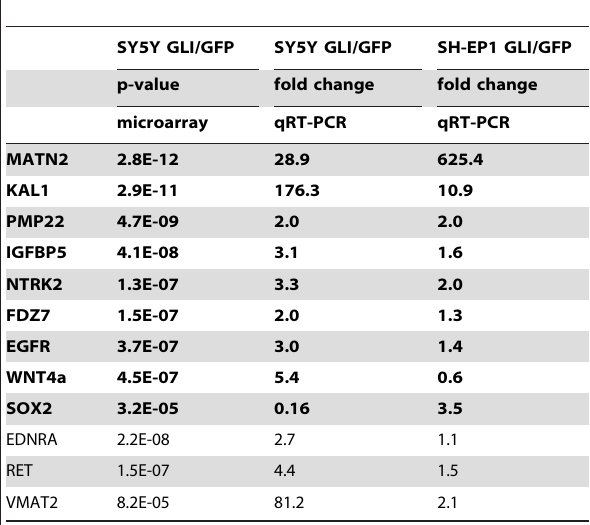
Table 3. Measured abundance of mRNA for select genes identified by microarray analysis as regulated by Gli1 in SY5Y cells.